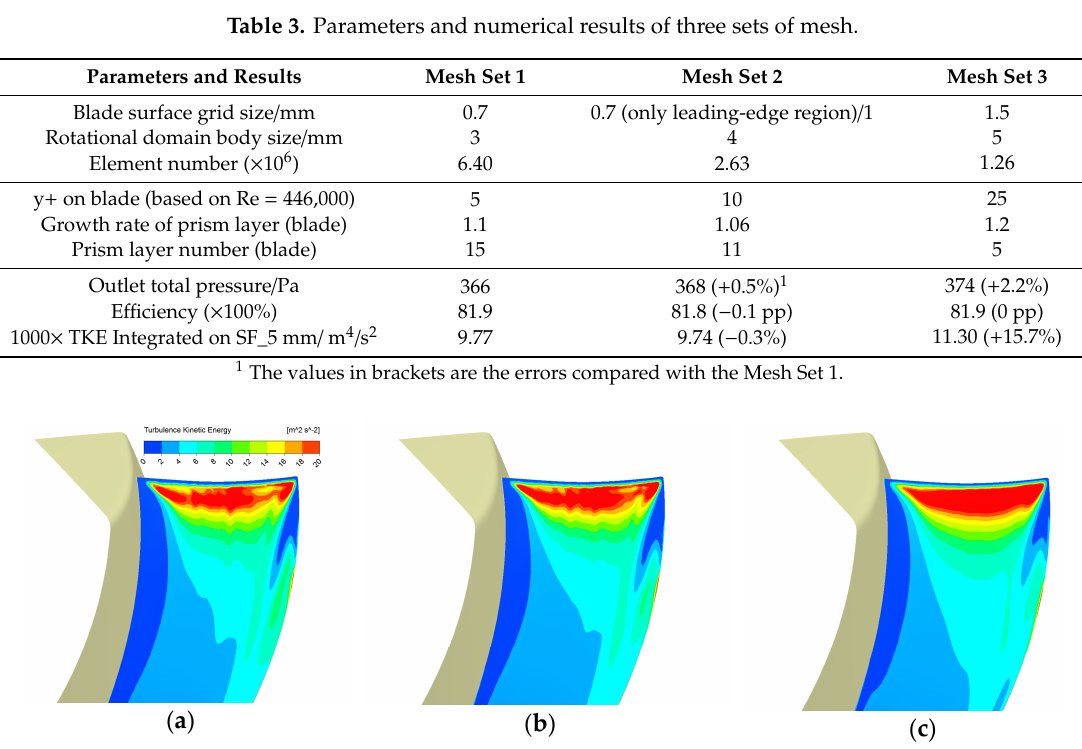
Figure 8. A verification of TKE results on Off_Suc_1 mm for different mesh sets: ( a ) Mesh set 1, ( b ) Mesh set 2, ( c ) Mesh set 3.